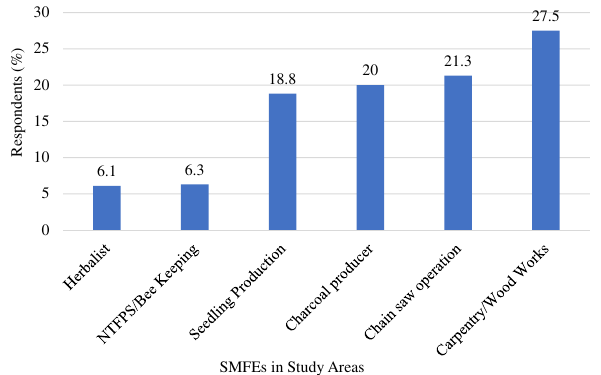
Figure 3. Various SMFEs in the Study Areas.